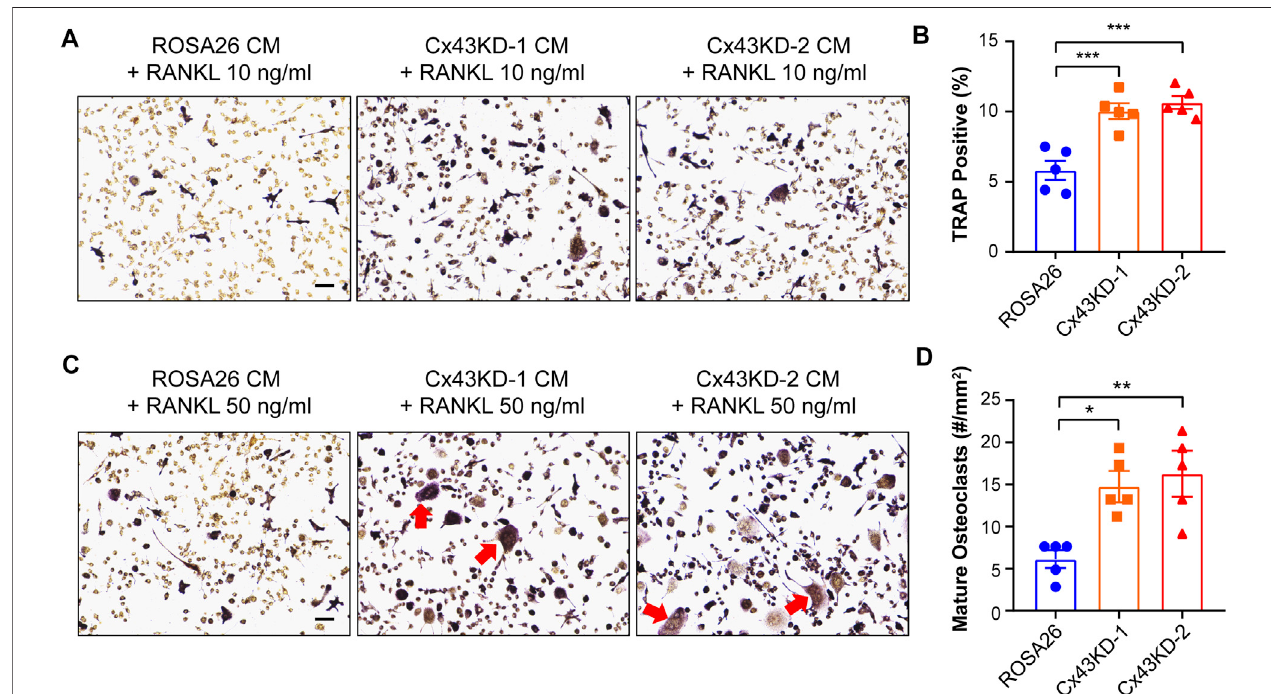
FIGURE 8 | Conditioned medium collected from differentiated IDG-SW3 cells with Cx43 knockdown promoted osteoclastogenesis of RAW264.7 cells. Representativeimages (A,C) ofTRAPstainingindifferentiatedRAW264.7cellsculturedinCMfromROSA26orCx43KDIDG-SW3cellswith10 ng/ml (A,B) or50 ng/ml RANKL (C,D) for 7 days. Scale bar, 50 μ m. T he percentage of TRAP-stained cells (B) and numbers of mature osteoclasts (D) were quanti fi ed by NIH ImageJ software. Data shown are mean ± SEM. *, p < 0.05, **, p < 0.01, ***, p < 0.001.